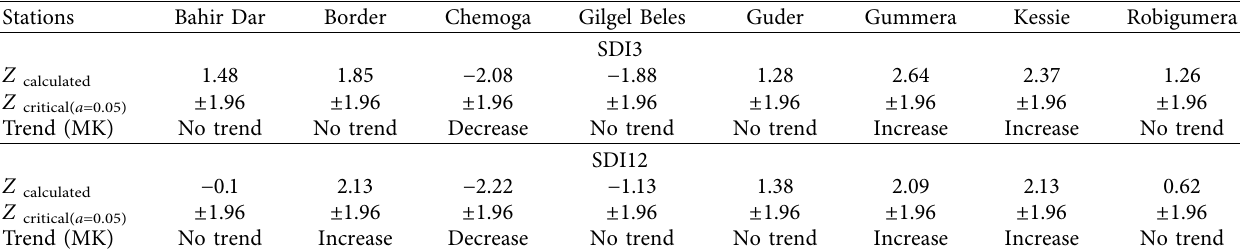
Table 6: Results of Mann–Kendall (MK) test for SDI3 and